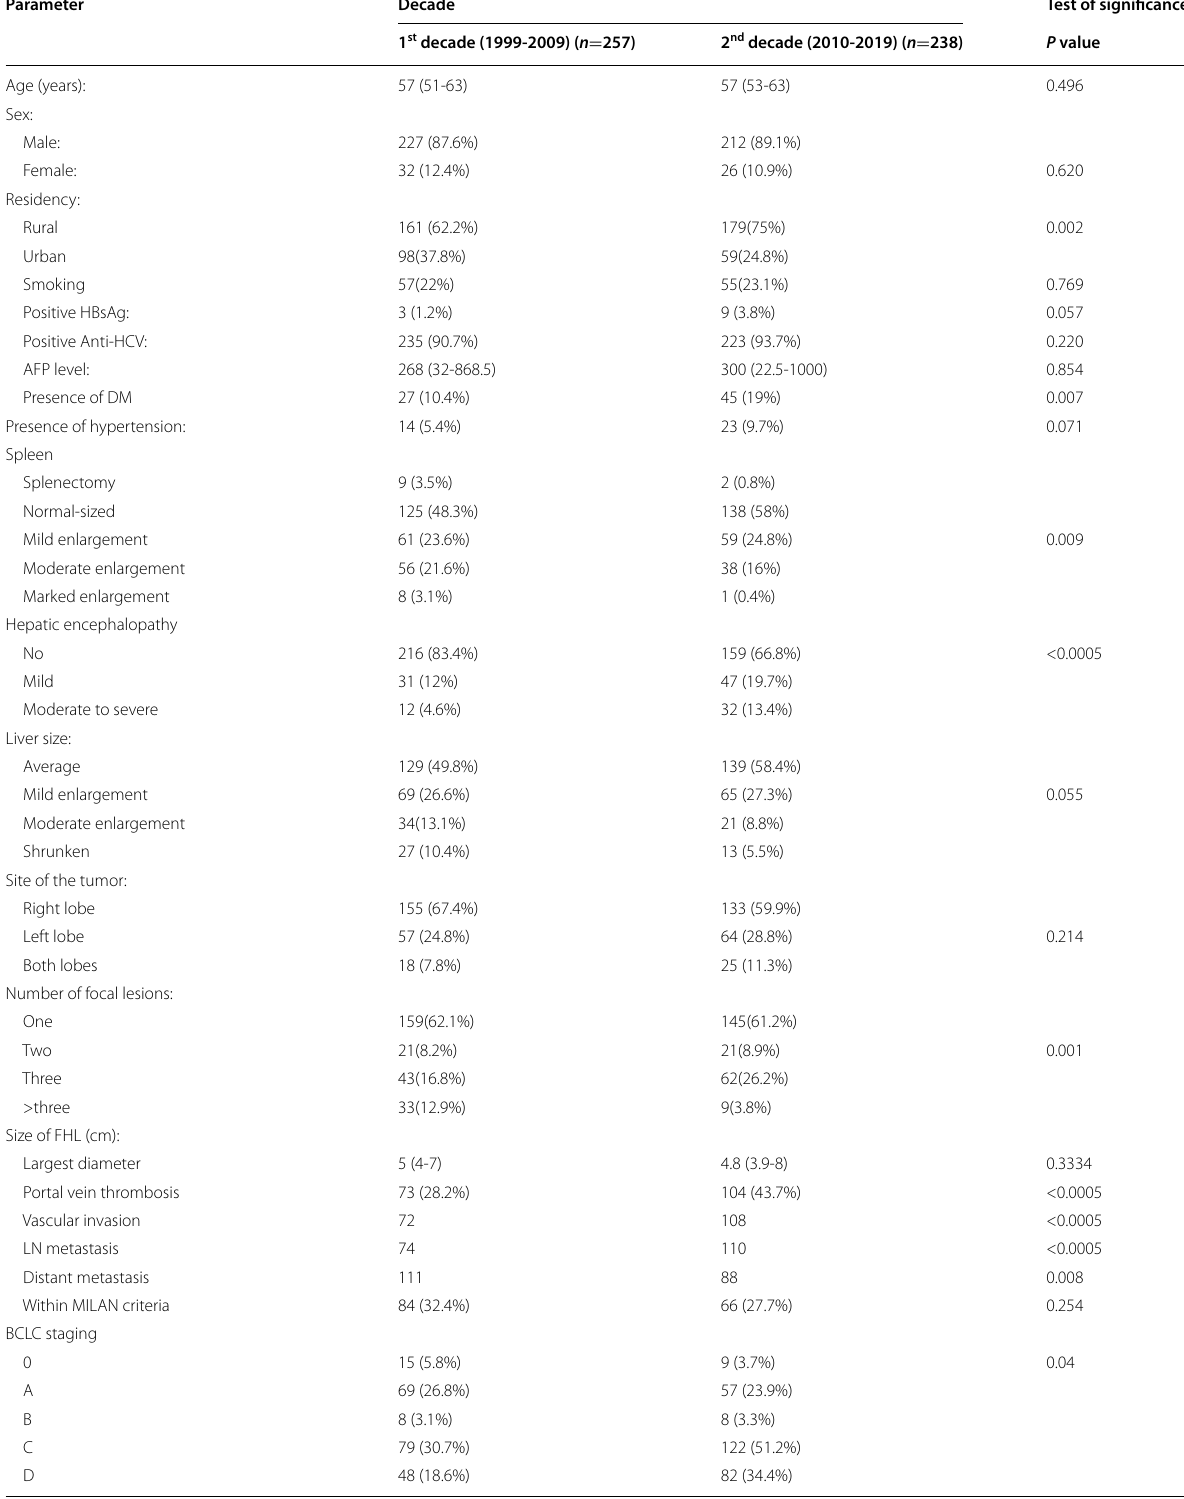
Table 2 Comparison of demographic, clinicopathological and radiological data between the 1st and 2nd decade Parameter Decade Test of